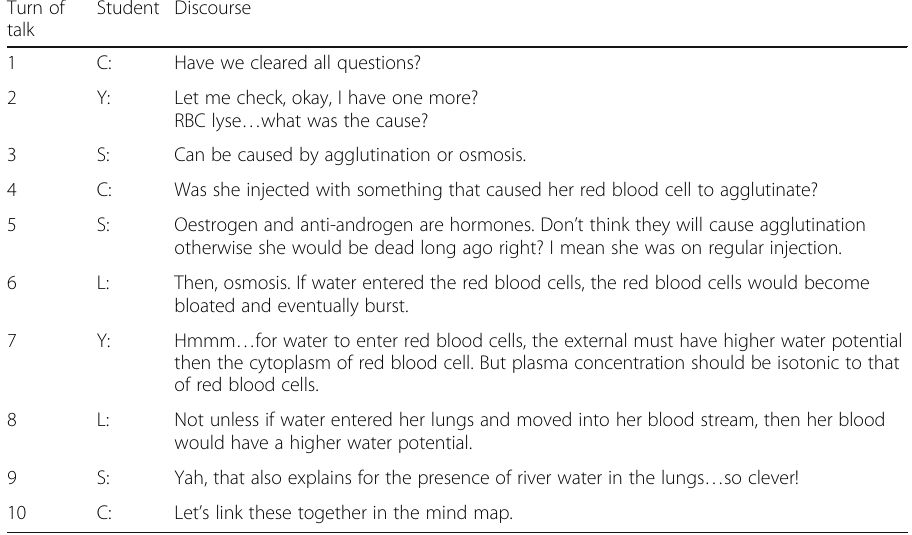
With this last question answered, group F then organized all the information they had recorded from answering questions that sought basic information into a mind map (see line 10). Figure 2 showed the mind map constructed by group F. Table 8, student L asked two key inquiry questions: “ how did the bubble get into the blood stream? ” and “ how did it eventually end up at the coronary artery? ” . The group then proceeded to look for key words in the key inquiry question asked. This was evident in line 13 of the transcript where student S identified bubbles and blocked coronary artery as the key words. Once the key words were identified, they traced and backtracked all pos- sible paths that branched from the identified words or phrases in the mind map. This was evident when line 13 and Fig. 2 were juxtaposed. In line 13, student C pointed to the “ bubbles enter the bloodstream ” found at point F on the mind map. Student C said “ Bub- bles enter bloodstream, so it is here, trace backwards, that ’ s from intravenous injection (refer to point D on mind map) … why need injection … because need to stay as a female